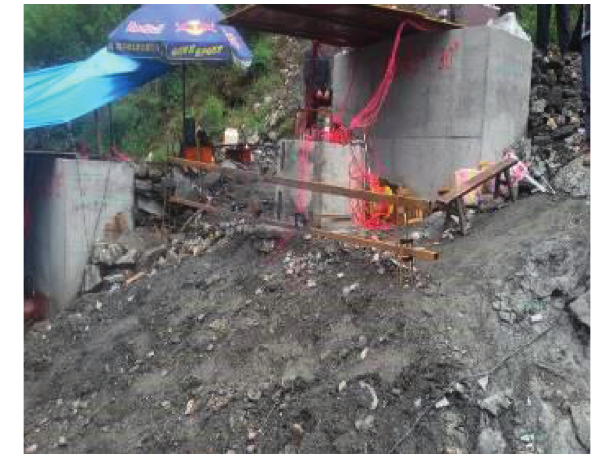
Figure 22: Field test under 30 °